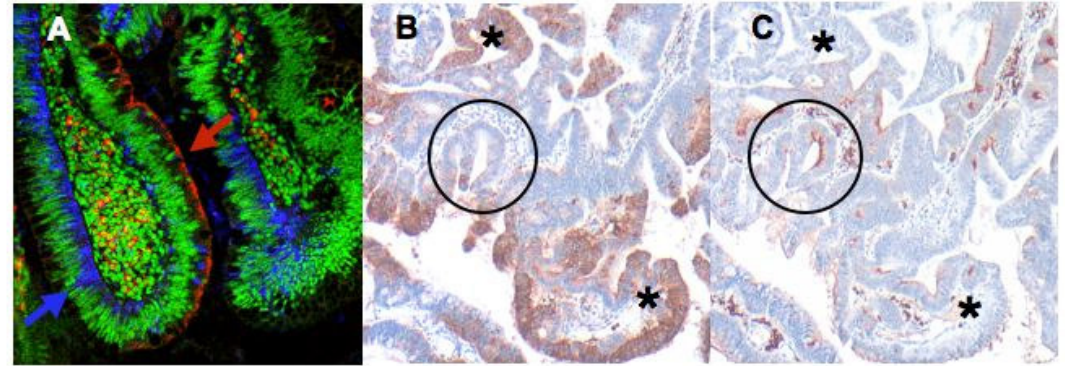
FIGURE 4. Coimmunostaining of Lgr5 and CD133 in colonic adenoma identifies distinct populations of cells. (A) Coimmunofluorescence of Lgr5 with Cy5 (blue) and CD133 with Alexa Fluor 568 (red) (40 × ). Nuclei (green) are stained with SYBR Green. Immunostaining of Lgr5 (blue arrow) and CD133 (red arrow) reveals distinct subpopulations of cells. (B) Adjacent section stained for Lgr5 (10 × ). (C) Adjacent section stained for CD133 (10 × ). The two subpopulations of cells were often in close proximity, but were distinct and mutually exclusive (circles and